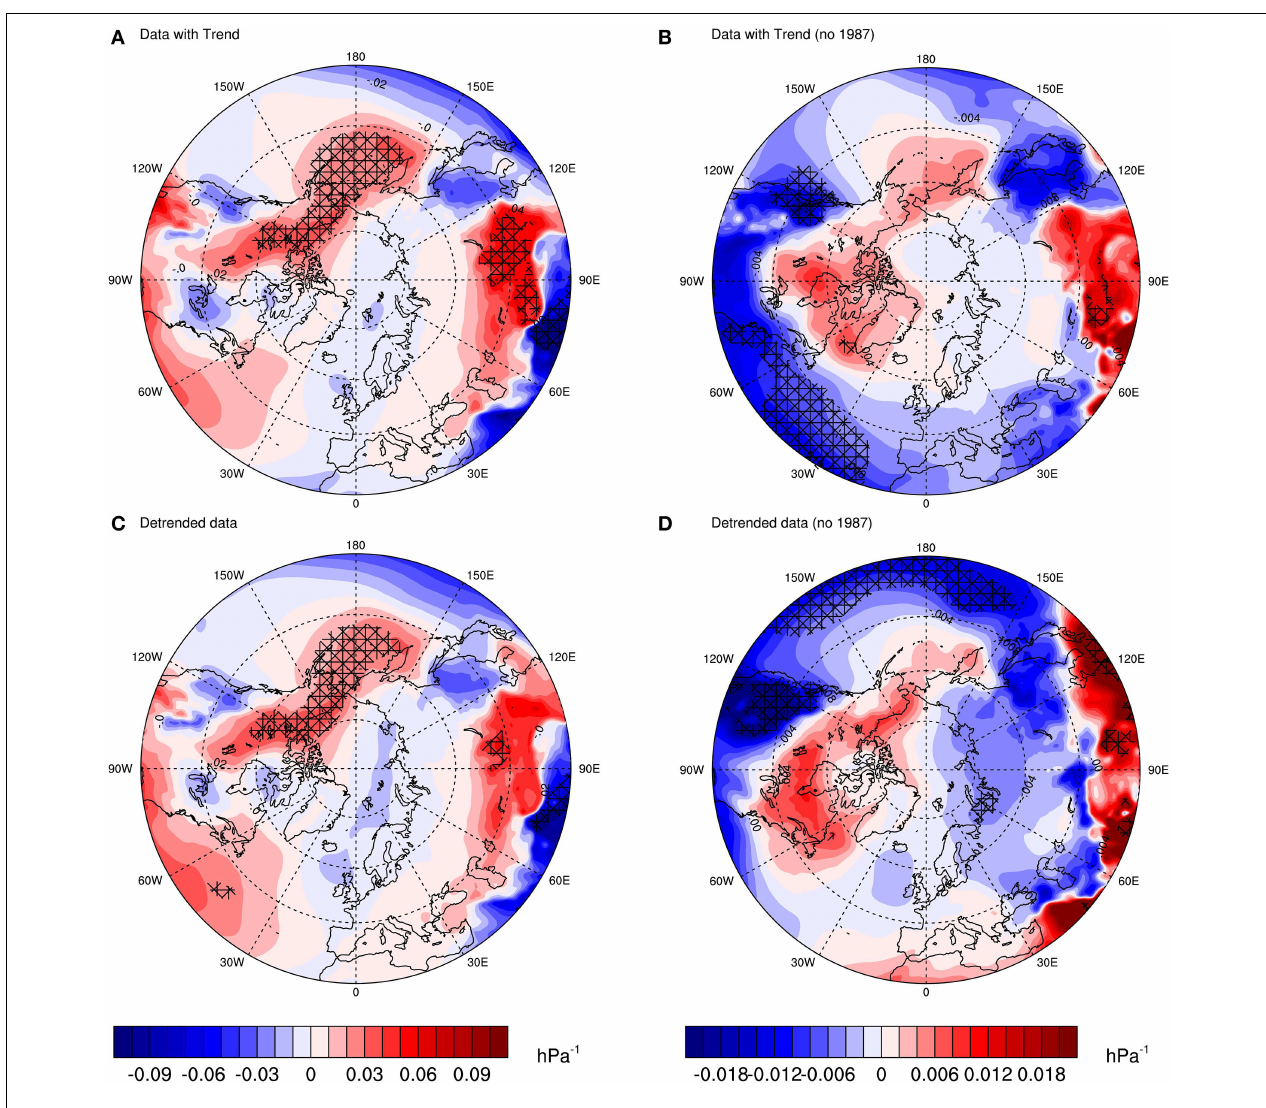
FIGURE 3 | Point linear regression coefficients between MSLP and guillemot population growth rate ( r ) based on the period 1980–2011. Each plot shows the regression coefficient between: (A) MSLP and raw r ; (B) MSLP and r with 1987 removed from both